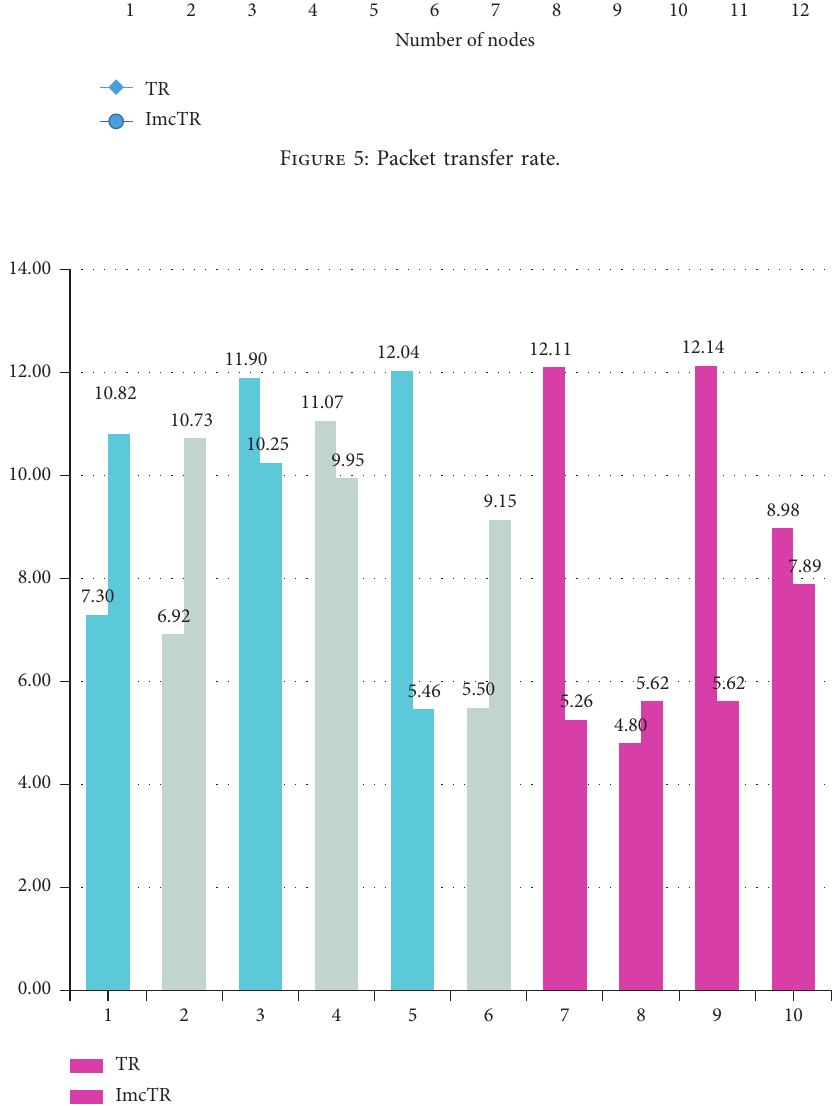
Figure 6: Routing efficiency.